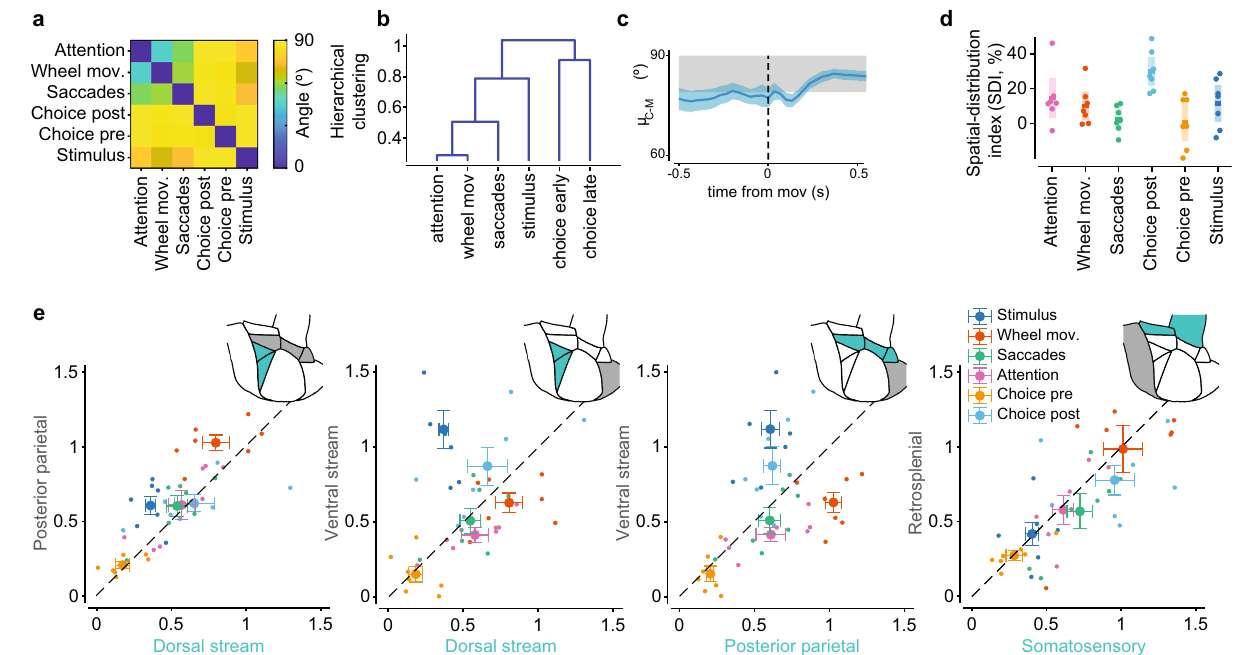
Fig. 4 | Choiceisdistributed,near orthogonalto othercomponents and witha ventral-stream dominance. a Angles betweenstate axesaveraged across animals. Choice axes (pre- and post-movement) were orthogonal to all other axes (smallest angle 84±7°). Attention and wheel had the smallest angular separation (44±3°), followed by wheel and saccades (56±4°). b Hierarchical clustering from the angle distances in a . Attentionand wheelmovements weremost similar.Choice pre-and post-movement onset clustered together, whereas stimulus and saccades had unique pro fi les. c Anglebetweenchoice andmovementstate axes averagedacross animals aligned to movement onset (line for average across animals and shaded area for its 95% CI, n =7 animals); shaded gray band is the expected angular dis- tance range for statistically independent axes; observed angles never signi fi cantly